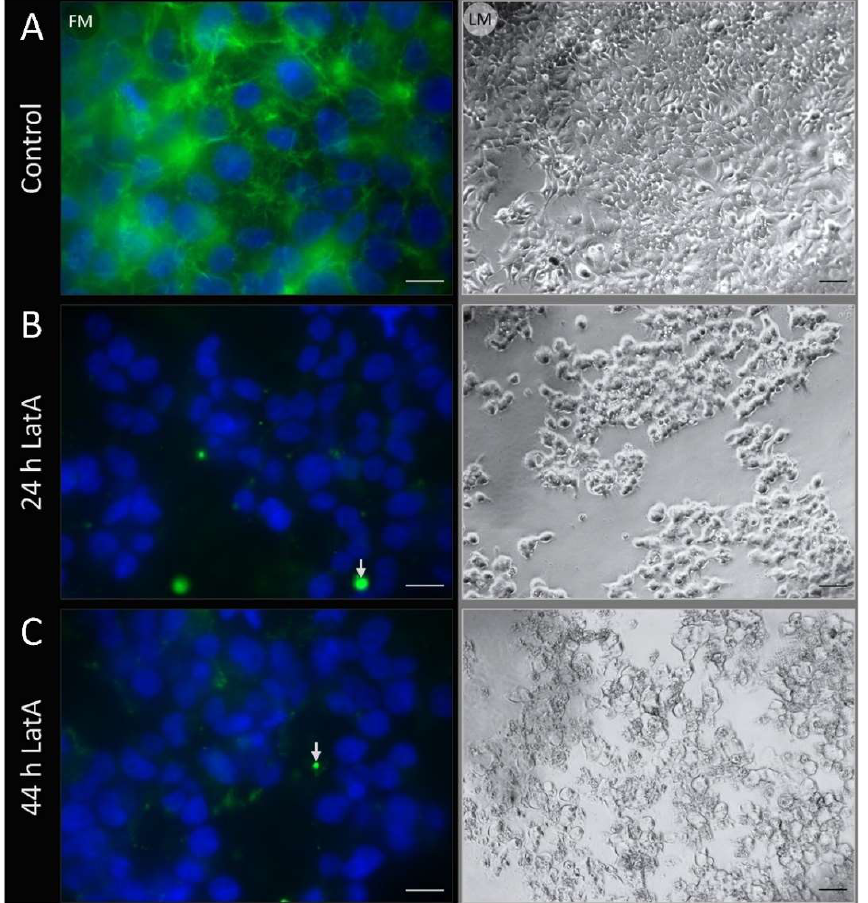
Figure 6. Cytoskeletal visualization of HEK-293 cells using fluorescent microscopy ( FM , left) with Phalloidin staining filamentous actin (green), and Hoechst staining DNA (blue), in comparison to light microscopy images ( LM , right column). Cells were incubated in DMEM medium ( A ) without LatA (control, 44 h), ( B ) with 50 µM LatA, isolated from Chromodoris nudibranchs for 24 h, ( C ) with 50 µM LatA for 44 h. Arrows mark condensed actin. Scale bars: FM = 20 µm; LM = 50 µm.